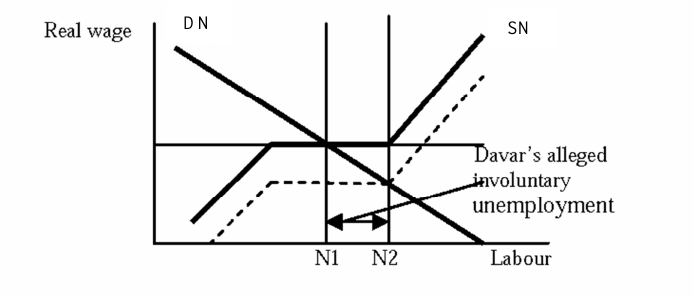
Figure 2. Davar’s “weakly increasing” aggregate supply curve of labour